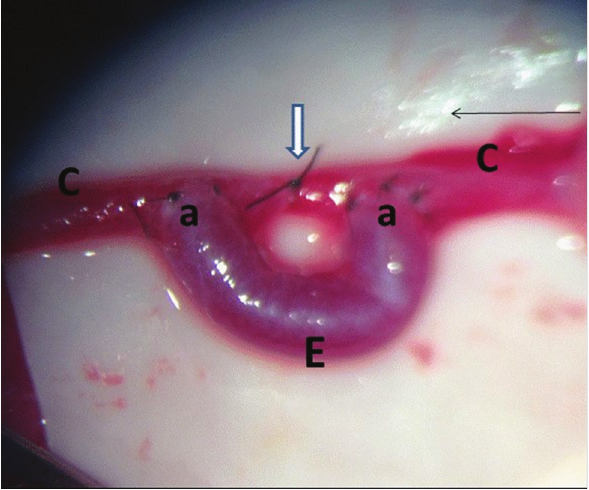
Figure 1 - Final aspect of the surgical procedure. C – left carotid; E – venous graft; a – end-to-side anastomoses; small arrow –